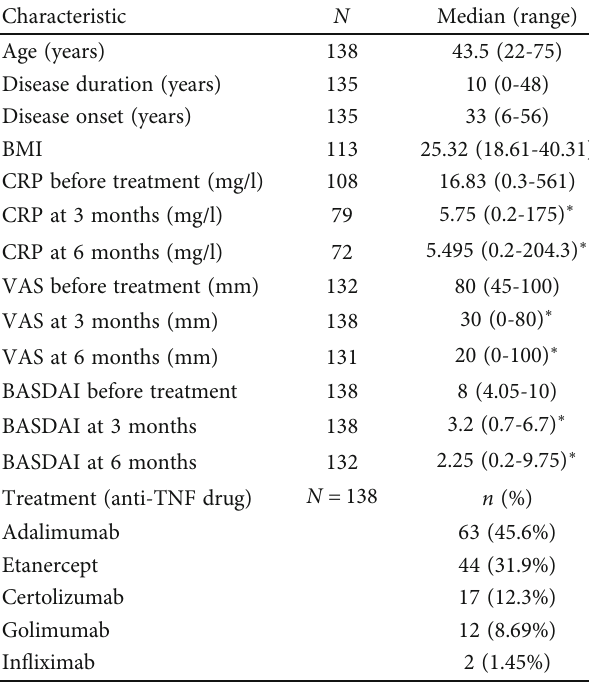
Table 2: The distribution of IL-17 genotypes and alleles in AS patients and the control